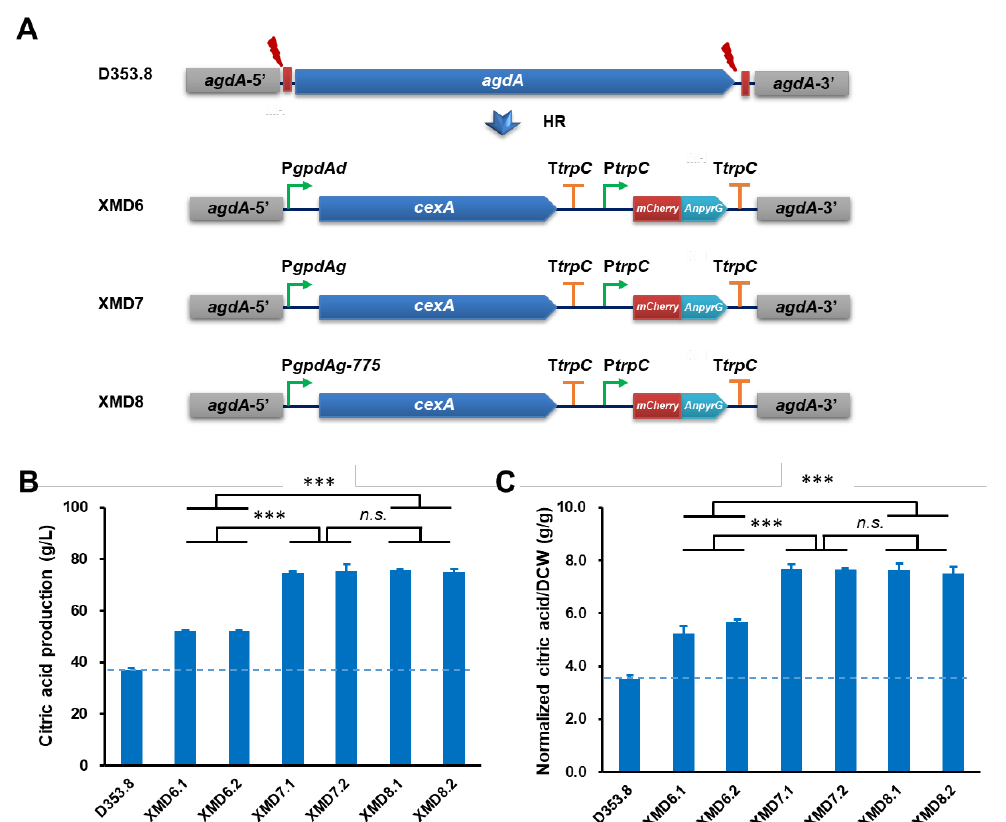
Figure 4. Citric acid production of A. niger strains expressing cexA under the control of the P gpdA promoter. ( A ) Schematic diagram of constructs expressing cexA under the control donor DNAs con- taining the P gpdA promoter. The donor DNAs containing P gpdAd :: CexA , P gpdAg :: CexA, and